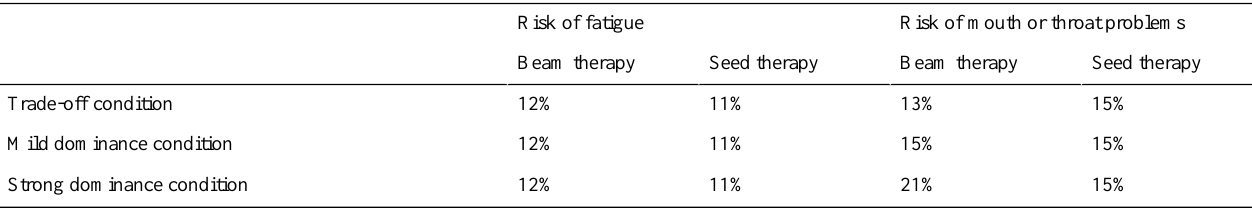
Table 1. Side-effect risks presented in the hypothetical vignette